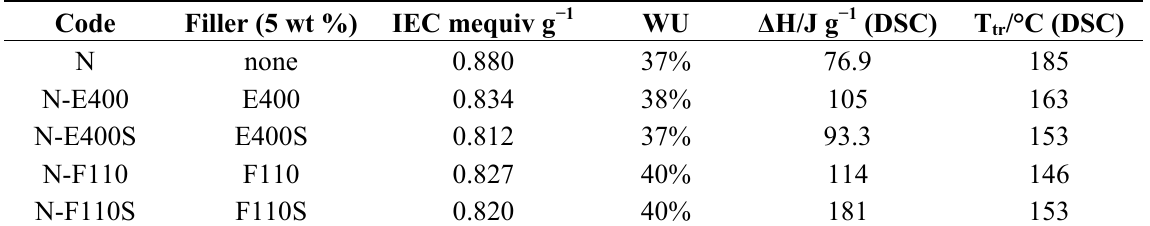
Table 1. Water uptake (WU), ionic exchange capacity (IEC), and parameters derived from the thermal analysis for the five prepared